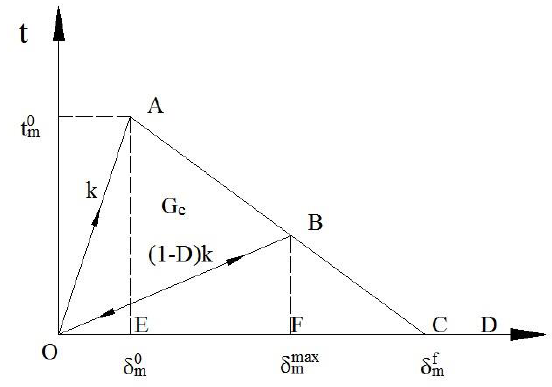
Figure 5. The load–displacement Figure 5. The load – displacement curves.